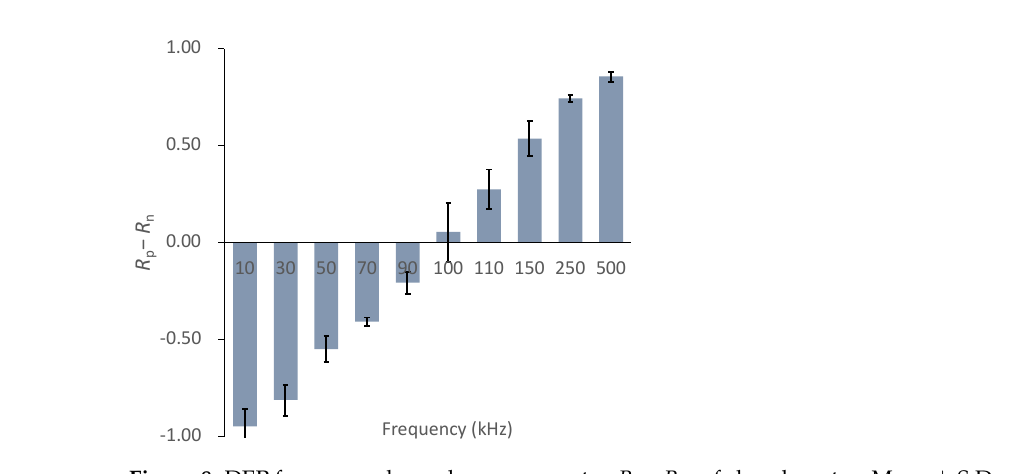
( b ) Figure 10. Calcein-AM staining of the agarose gel-sheet constructs cultured for 7 days. Fluorescence images captured from ( a ) the horizontal plane and ( b ) the cross section. There were no significant differences in the sGAG contents of the specimens from the three experimental groups (Figure 11). There were also no significant differences in the number of cells among the three experimental groups (Figure 12). The sGAG contents and cell numbers of specimens in all experimental groups increased with increasing culturing time. 100 µ m